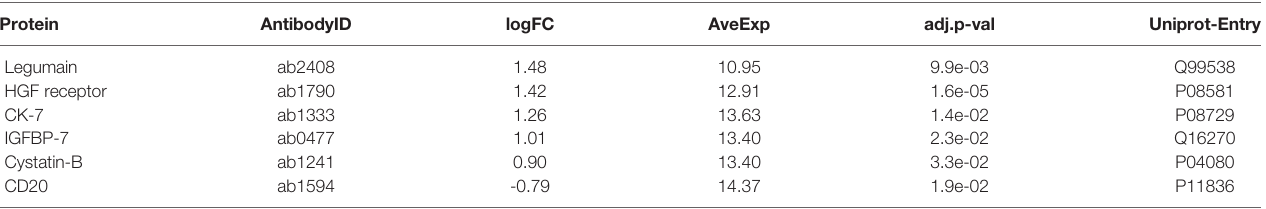
TABLE 1 | Proteins with differential abundance in END samples ( fi nal visit) and START samples (baseline visit). Protein